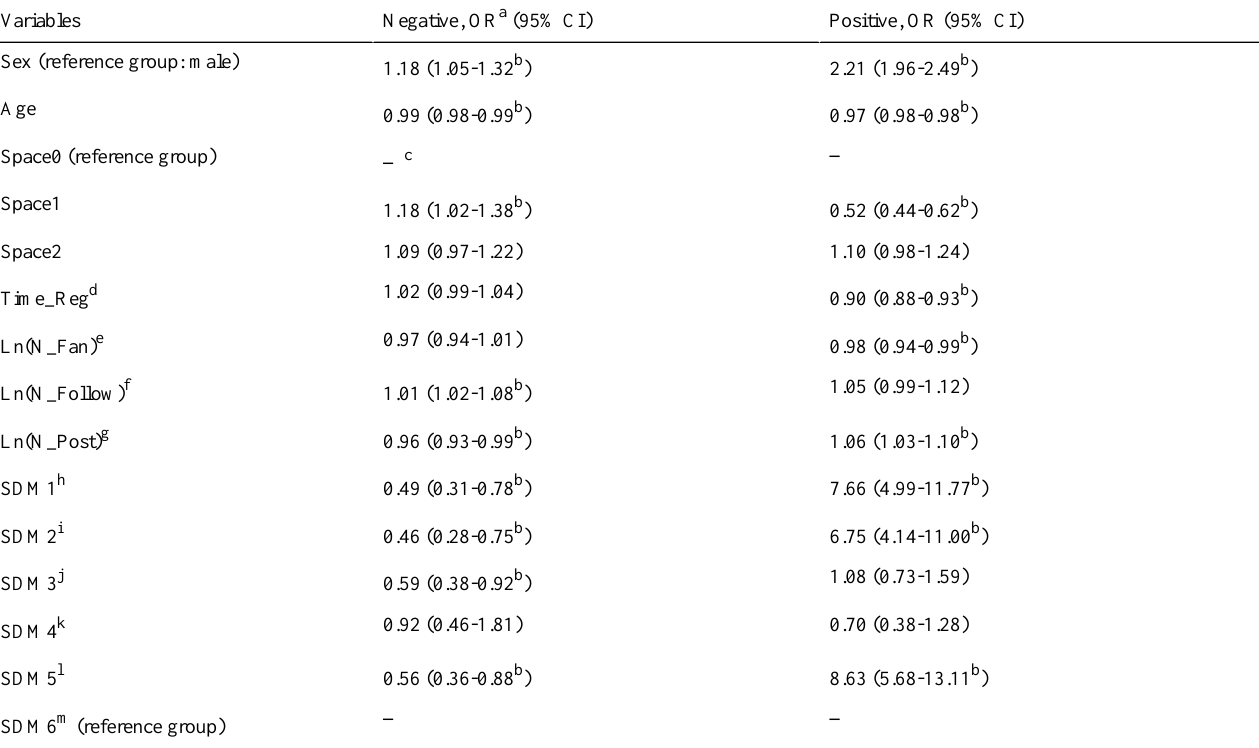
Positive, OR (95% CI)Negative, OR a (95%